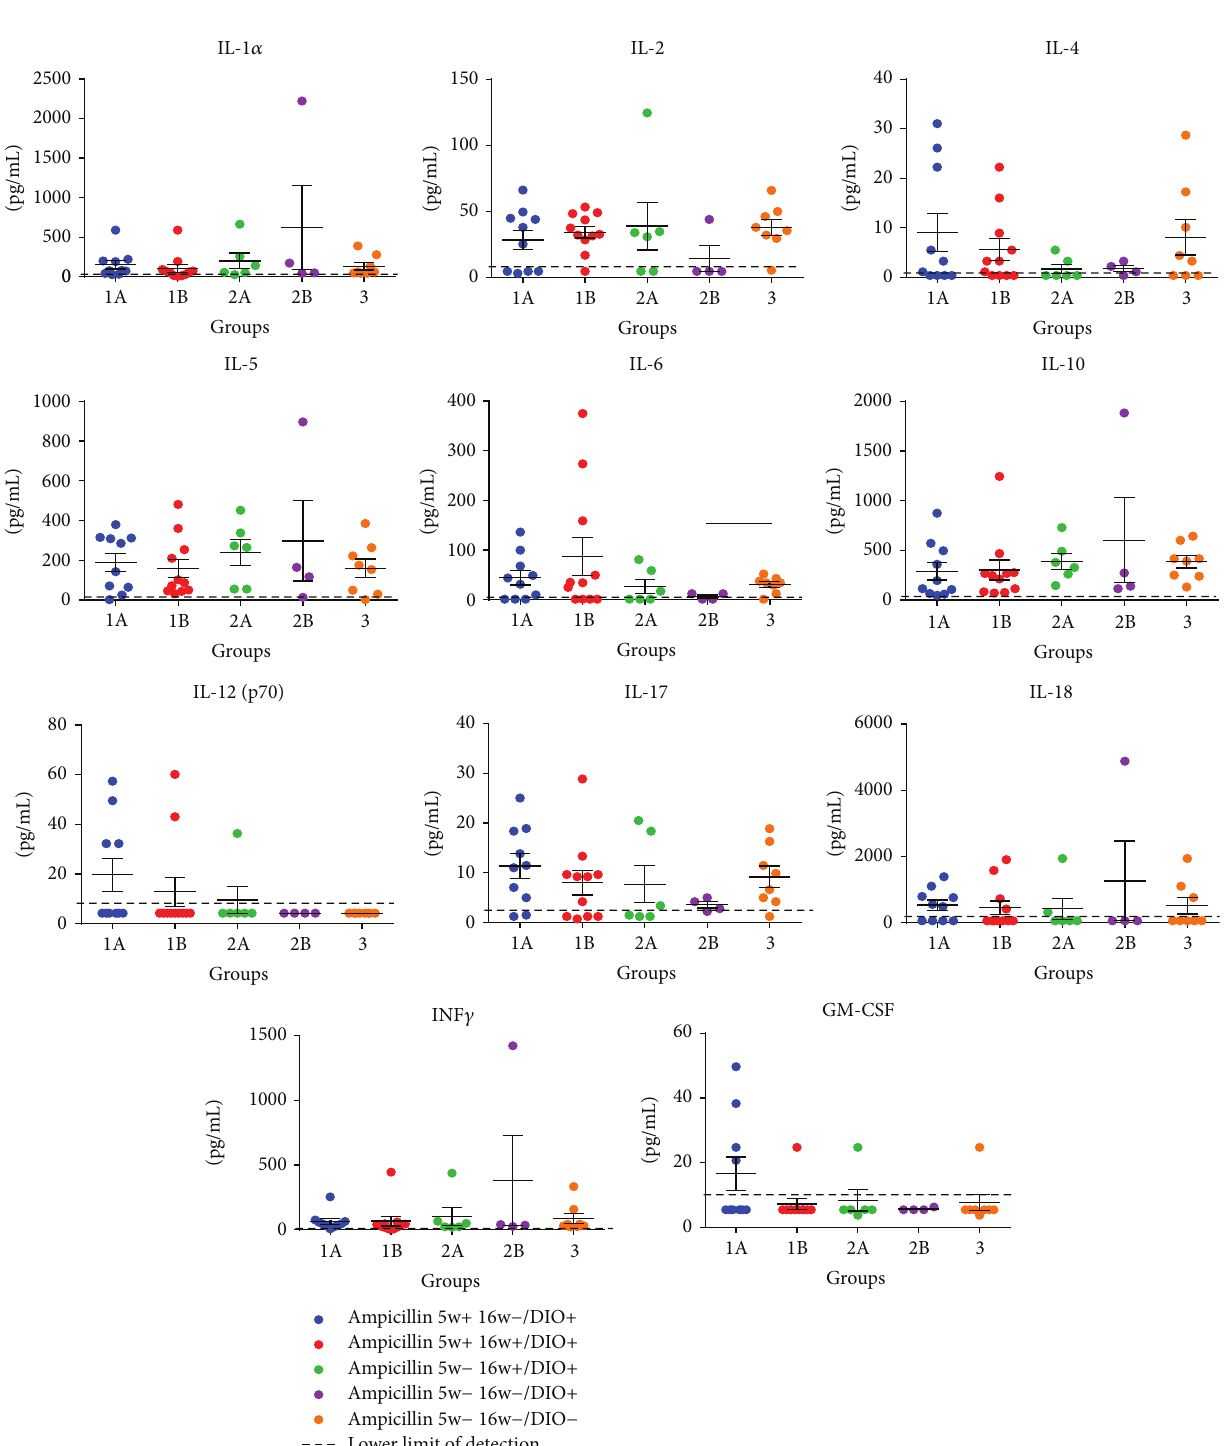
Figure 3: Levels of various plasma cytokines measured at week 17 at termination of the study (mean and SEM). IL-6 was statistically significantly higher in the low-fat fed group 3 (Ampicillin 5w − 16w − /DIO − ) compared to the nontreated high-fat fed group 2B (Ampicillin 5w − 16w − /DIO+) ( 𝑃 = 0.039 ). TNF 𝛼 levels (not shown) were also measured, but all measurements were under detection